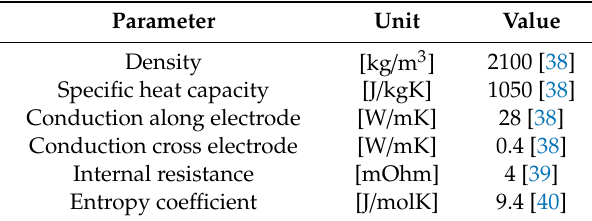
Table 3. Battery cell material values according to Loges et al. [38], Richter et al. [39], and Viswanathan et al. [40].